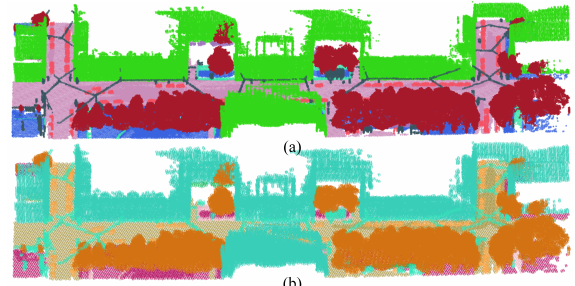
Figure 3. (a) and (b) Labeled 3D space with resolutions of 0.5 m and 1.0 m.